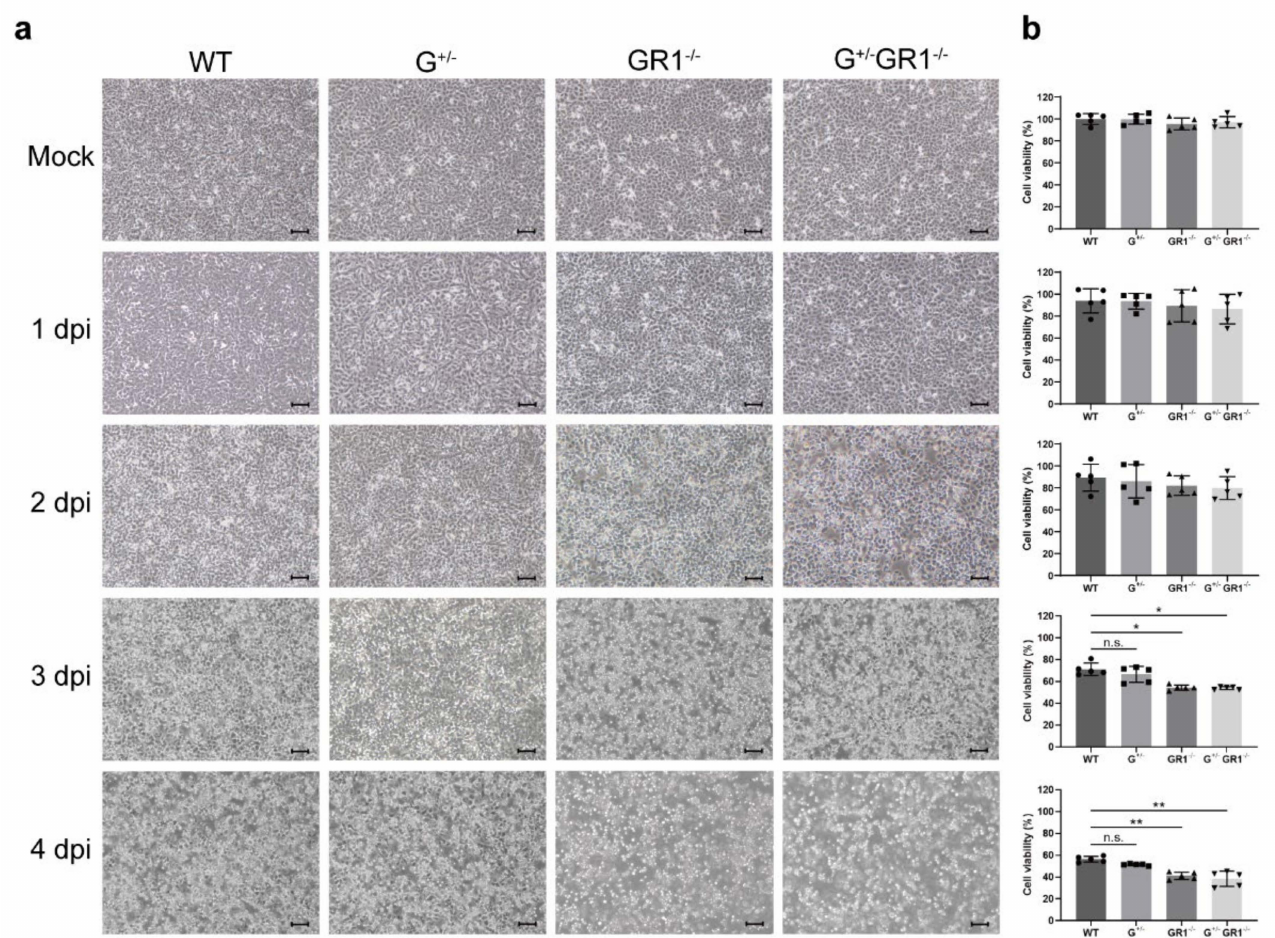
γ -responsive transcription factors and cytokines remained low even after HCoV-OC43 infection in IFNG - and IFNGR1 -knockout cell lines, potentially facilitating viral replication.